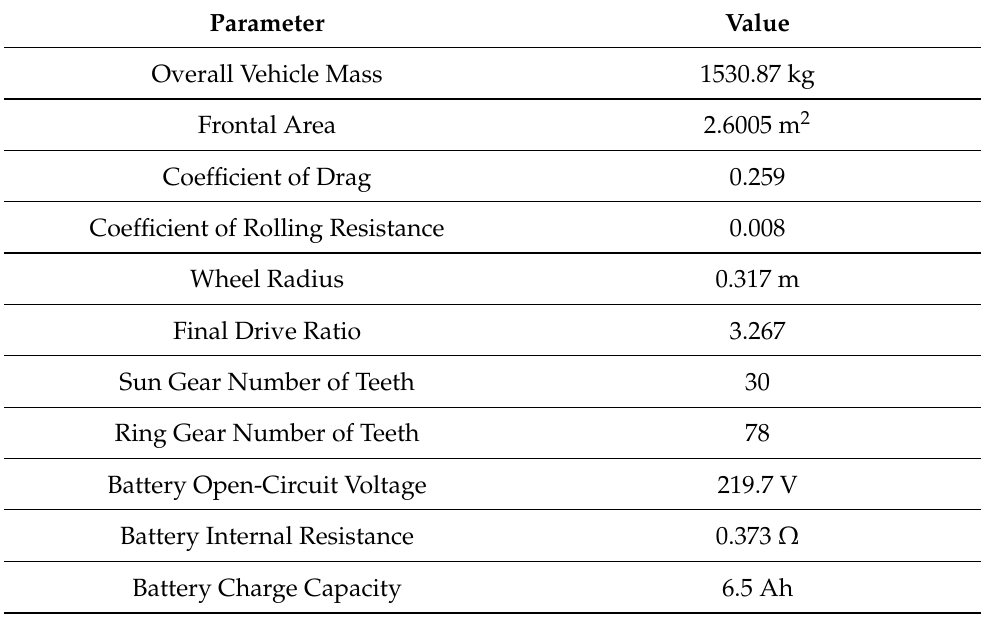
Table 6. Parameters and values for the Autonomie 2010 Toyota Prius Model.